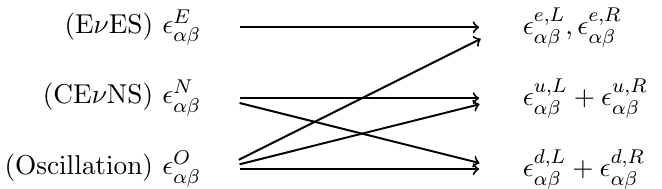
Figure 2 . A cartoon of the dependencies of the phenomenological NSI on the physical NSI. E (cid:23) ES experiments may gain sensitivity to the left and right chiral e -NSI, while CE (cid:23) NS and oscillation experiments are only sensitive to the vectorial combinations of u; d and e; u; d NSI,